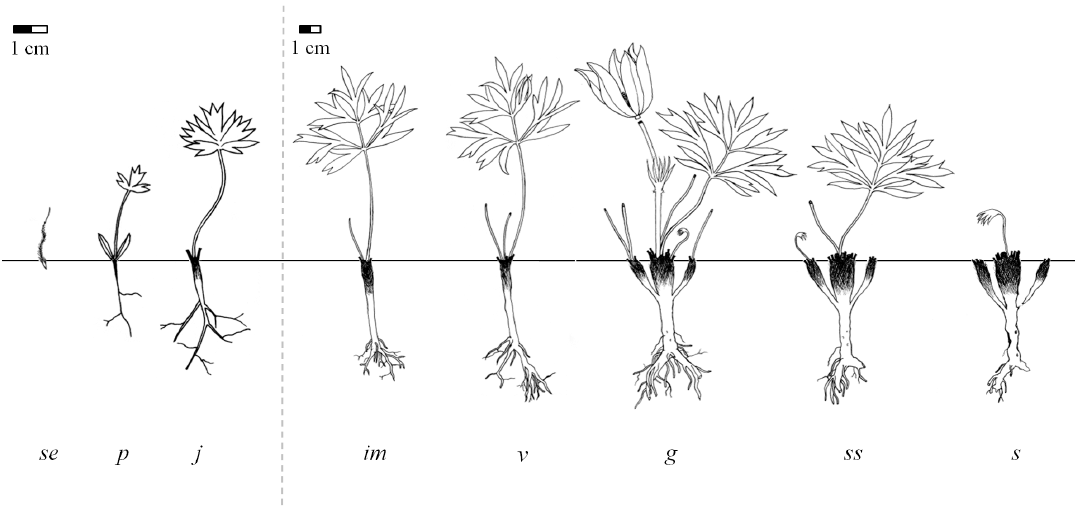
Figure 2. Schematic drawing of different life stages of Anemone patens : se—seed, p—seedling, j—juvenile, im—immature, v—virginile, g—generative, ss—subsenile, and s—senile. Drawing by Yakiv Ponomarenko. Table 1. Morphological characteristics of young individuals (p, j, im) of Anemone patens ( n = 10 for each life stage). In the numerator is the mean ( ¯ X) and its standard error ( ˘ SE ), and in the denominator the coefficient of variation ( %CV